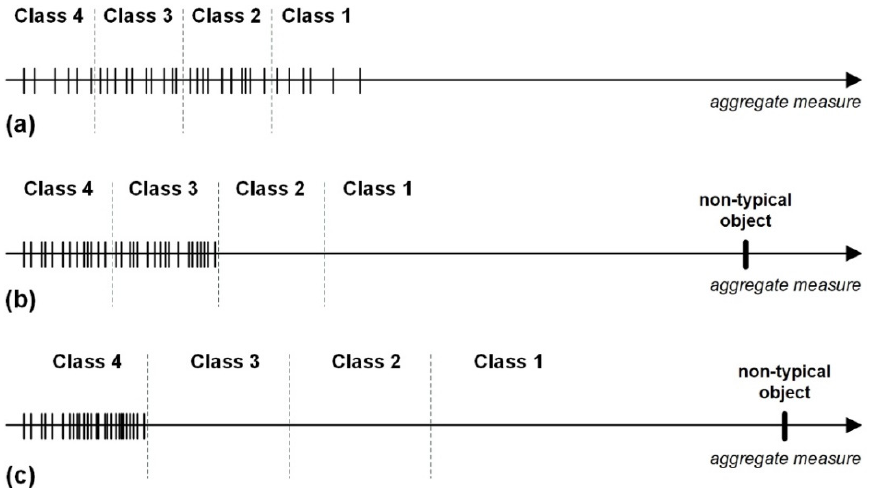
Figure 3. Object classification: ( a ) without non-typical object; ( b ) with non-typical object; ( c ) with non-typical object with even larger value difference.